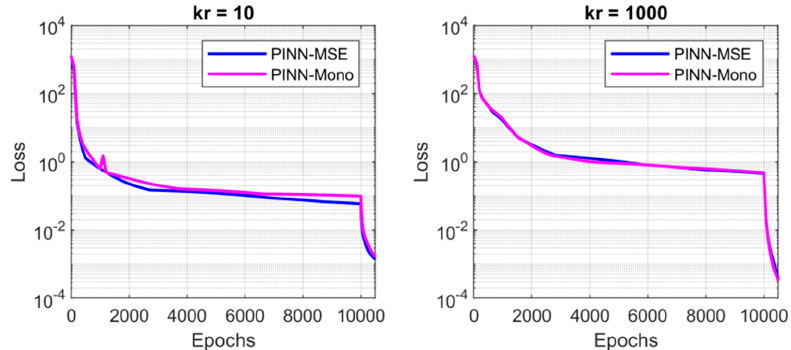
Figure 10. Loss history of PINN for case 2. Left: 𝑘 (cid:3045) = 10 ; right: 𝑘 (cid:3045) = 1000 .